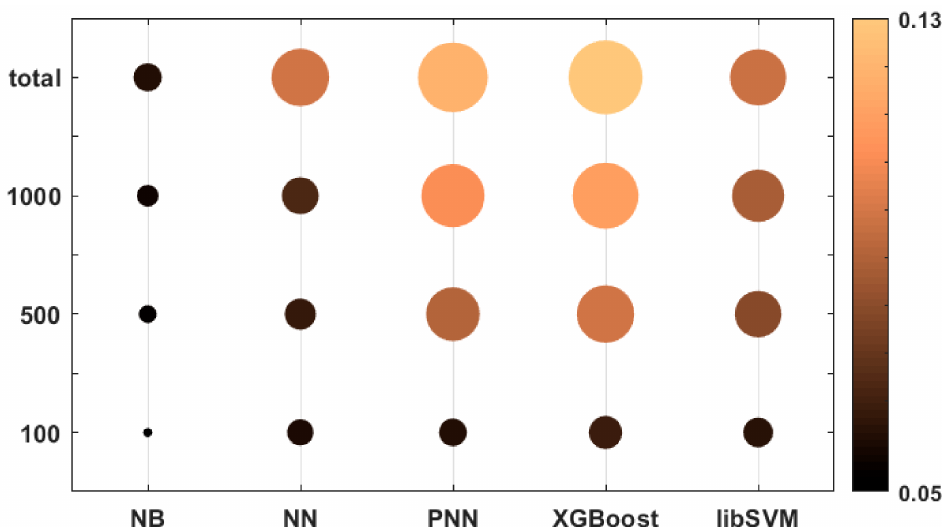
Figure 3. Bubble plot of the performances of the machine learning algorithms at different dataset sizes. Both the colors and the radii of the circles correspond to the average of the 25 normalized performance parameter values. (The bigger (and brighter) the